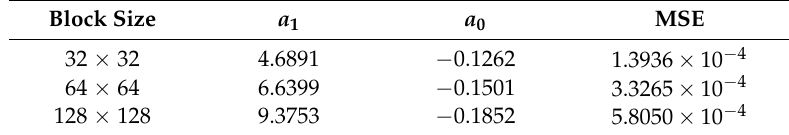
Table 2. The coefficients of the proposed α model for different choices of image block size.